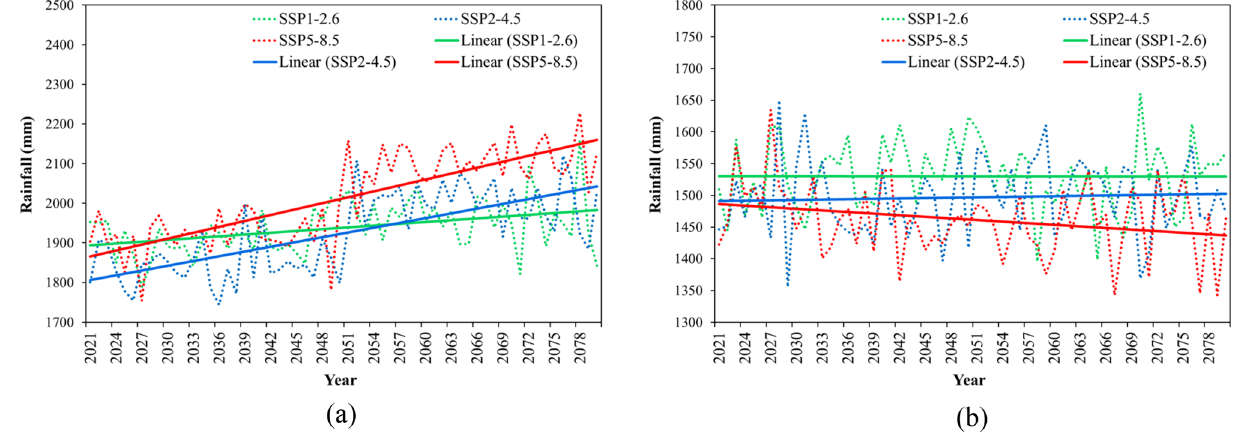
Fig. 9 Projected ensemble annual rainfall under SSP1-2.6, SSP2-4.5, and SSP5-8.5 scenarios over 2021–2080 for a main-season and b off-